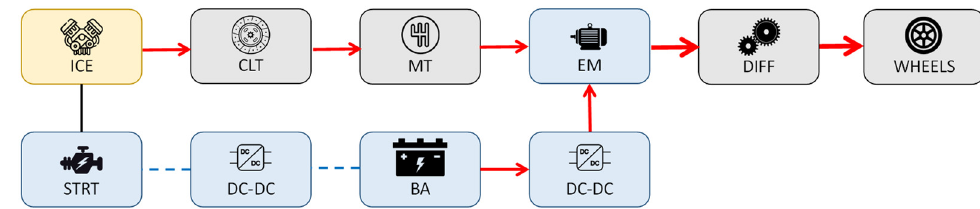
Figure 7. Energy fluxes in pure thermal mode with EM support.